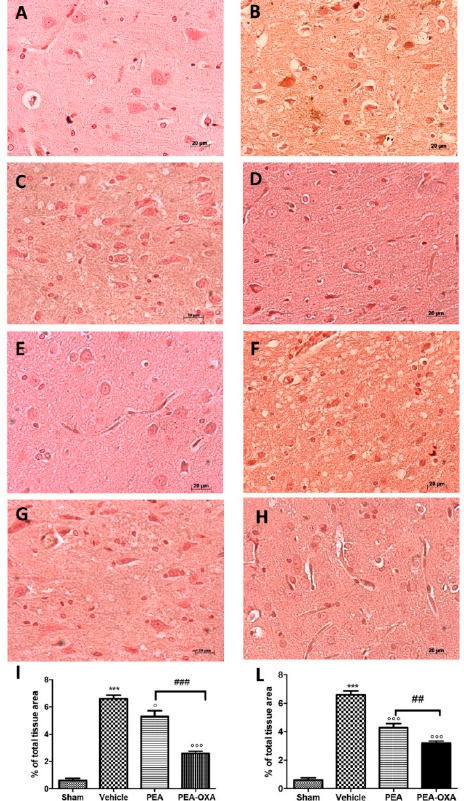
Figure 7. Efficacy of PEA-OXA on TNF- α and IL-1 β expression (induced by transient MCAo). Twenty-four hours after transient MCAo, an increased expression of TNF- α ( B , I ) and IL-1 β ( F , L ) was found in sections obtained from vehicle-treated rats compared to the sham-operated animals ( A , I ; E , L ). PEA-OXA administration reduced both TNF- α ( D , I ) and IL-1 β ( H , L ) expression more effectively than PEA did ( C , D ; G , L ). For the immunohistochemistry, a 20× magnification is shown (50-µm scale bar). A p -value of less than 0.05 was considered significant: * p < 0.05 versus sham; ° p < 0.05 versus vehicle; ** p < 0.01 versus sham; °° p < 0.01 versus vehicle; *** p < 0.001 versus sham; °°° p < 0.001 versus vehicle; # p < 0.05 versus PEA; ## p < 0.01 versus PEA; ### p < 0.001 versus PEA.